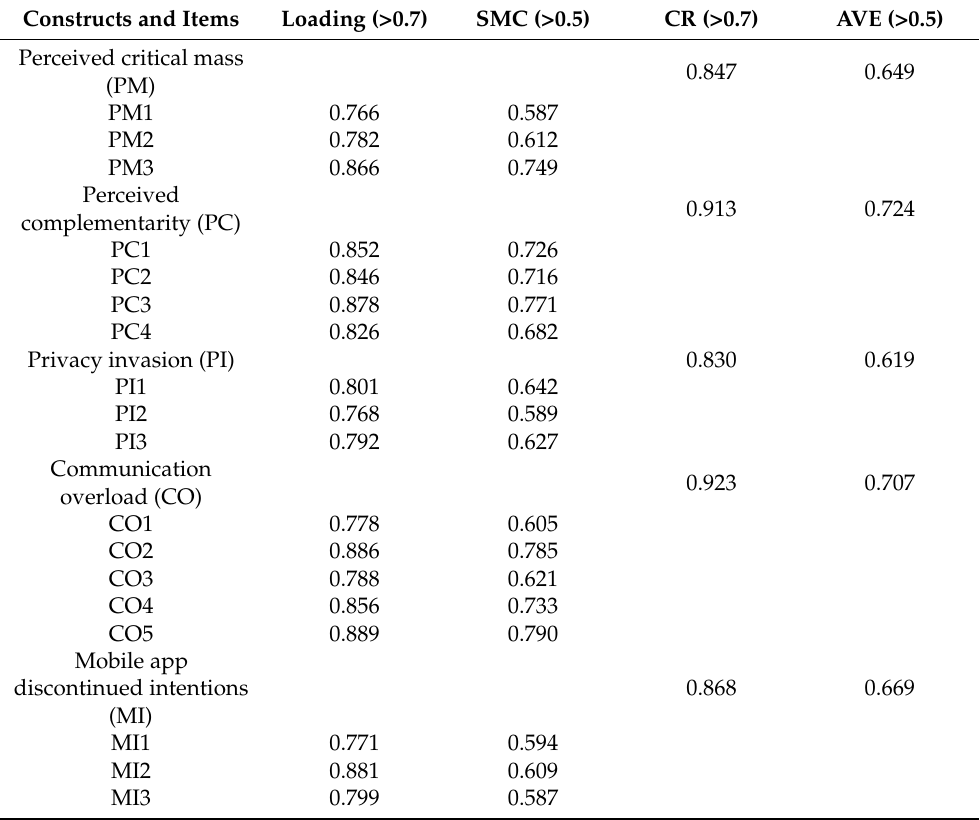
Table 3. Statistical outcomes of confirmatory factor analysis.